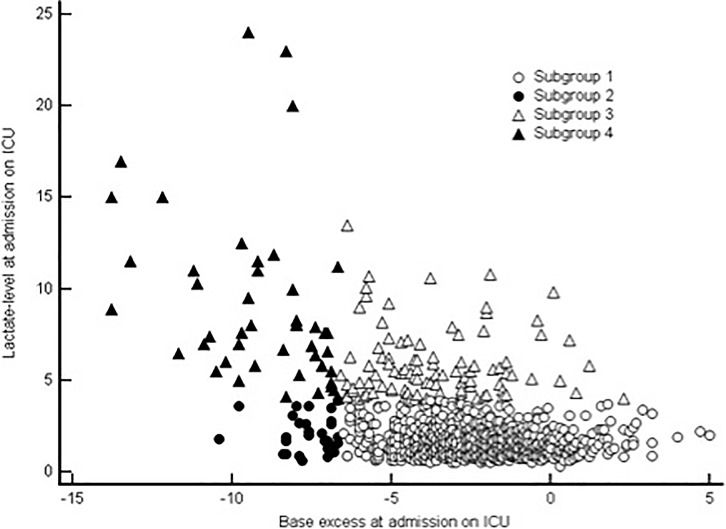
Scatterplot of lactate and base excess levels at admission on ICU after cardiac surgery.1st group: Lactate ≤3.9mmol/l and BE > -6.7 (n = 887): r = -0.1, p = 0.002, 95%-CI -0.17 to –0.04 2nd group: Lactate ≤3.9mmol/l and BE ≤ -6.7 (n = 28): r = -0.06, p = 0.78, 95%-CI -0.42 to 0.32 3rd group: Lactate >3.9mmol/l and BE > -6.7 (n = 96): r = -0.06, p = 0.58, 95%-CI -0.27 to 0.15. 4th group: Lactate >3.9mmol/l and BE ≤ -6.7 (n = 47): r = -0.36, p = -0.01, 95%-CI -0.59 to -0.08 Overall correlation (n = 1058): r = -0.48, p<0.0001, 95%-CI -0.52 to -0.43.